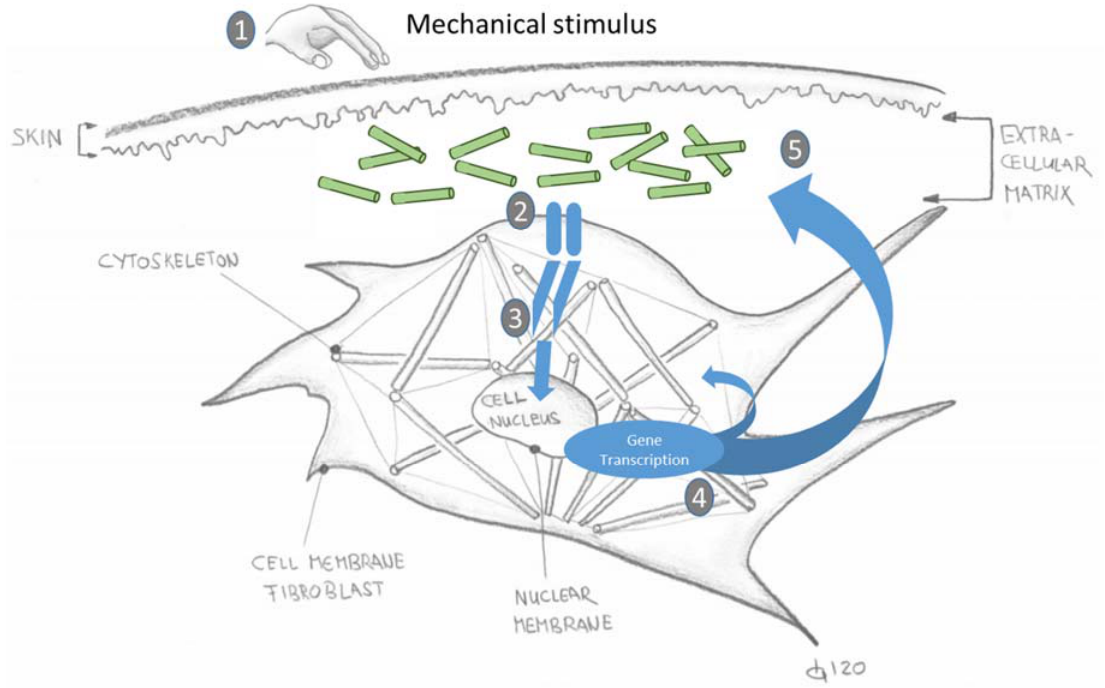
Figure 4. Schematically depicted mechanotransduction process of the reaction of a fibroblast cell to an external mechanical stimulus [8,12,14–18] (simplified graphic: T. Koller). Legend: 1. A mechanical stimulus is applied by a physiological movement or manual input by hand. (2).